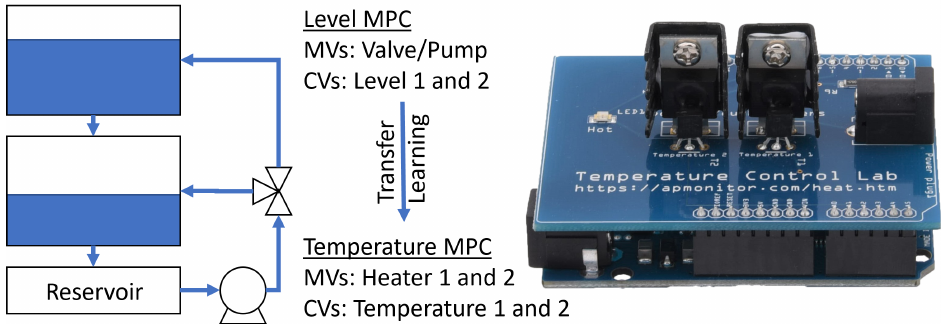
Figure 4. Overview of the transfer learning between liquid level MPC and temperature MPC.